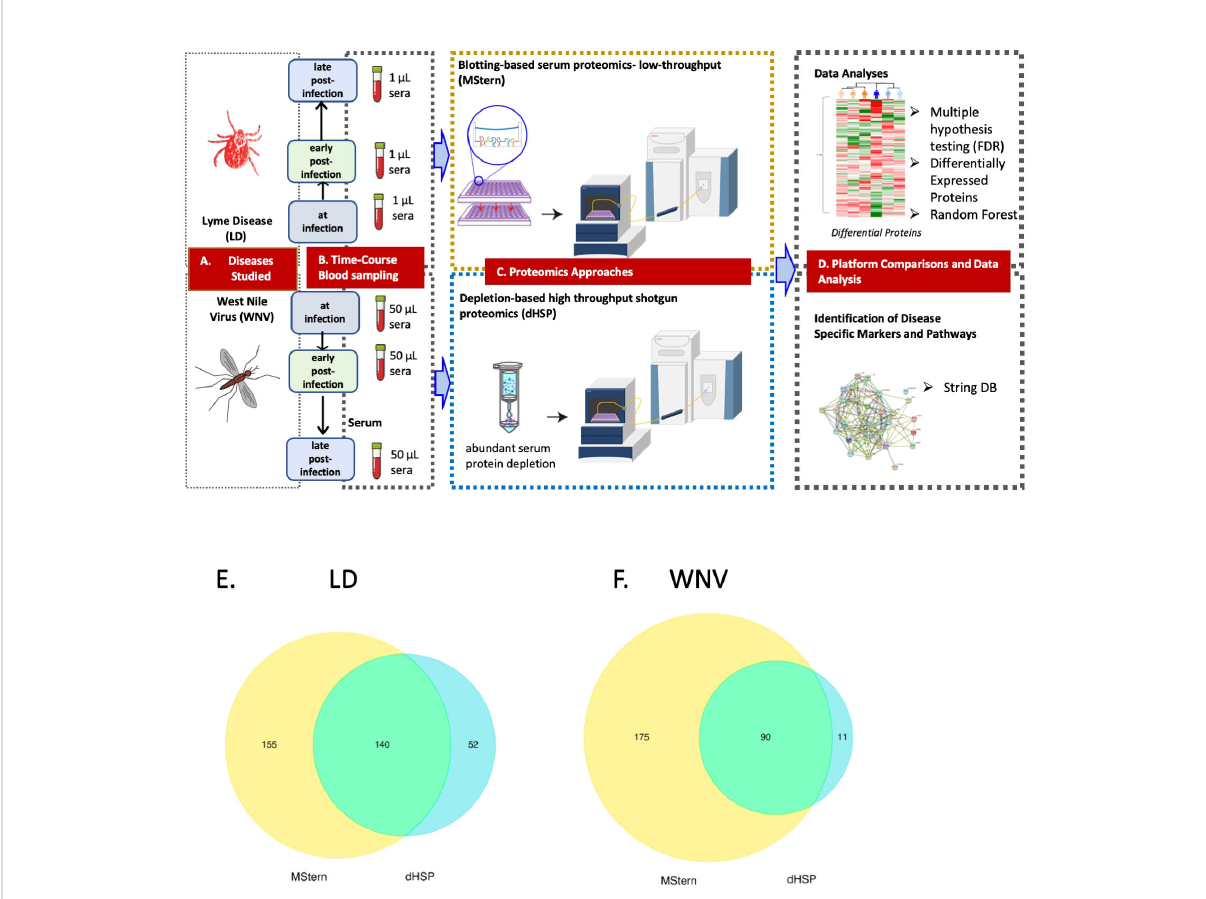
FIGURE 3 LEGEND - Schematic representation of the overall study. (A) Diseases studied- Lyme disease (tick-borne) and West Nile Virus infection (mosquito-borne). (B) Blood collection by venipuncture and serum separation (C) Serum protein processing platforms – MStern spotting of one µl serum on PVDF microtiter membrane without depleting high abundant protein followed by protein denaturation, reduction and alkylation of cysteine residues, rapid protein digestion, LCMS (top panel) and dHSP with depletion of high abundance blood proteins using spin columns followed by protein denaturation, reduction and alkylation of cysteine residues, rapid protein digestion and LCMS shotgun proteomics (bottom panel) (D) Data analysis and data interrogation for marker discovery and underlying molecular mechanisms. Venn Diagram of the analyzed proteins from both the dHSP and MStern platforms in LD (E) and WNV (F) . The optimized depletion-based method is an unbiased approach that was based on shotgun proteomics method that required 50 m l serum for depletion step and 1 m g of tryptic peptides for LC/MS analysis. The MStern platform starts with 1 m l serum on a 96 well-plate-based method with no depletion step required in